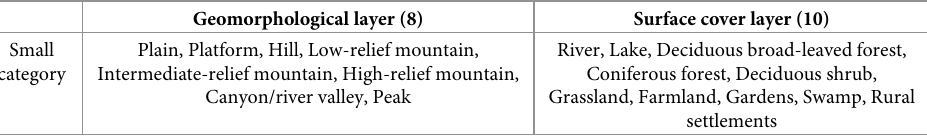
Table 3. Types of scenic resources.